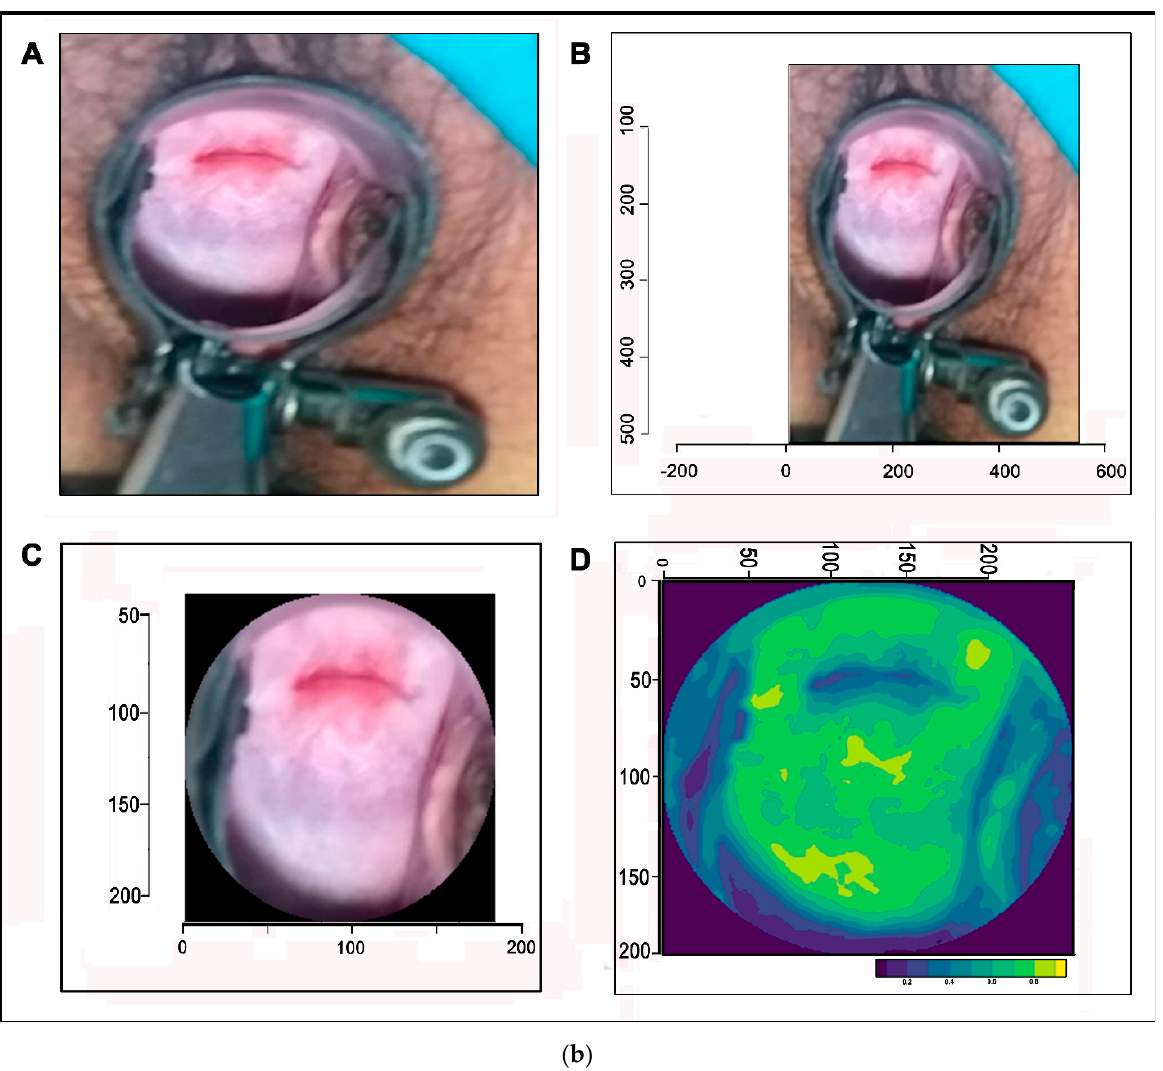
Figure 2. ( a ) Diagrammatic representation of the image processing of normal cervigrams: it de- picts the processing of the normal cervigrams A by subjecting it to preprocessing algorithms to remove the noise potentially interfering with the extraction of the image features before being processed with green channel color-coding algorithms and the Earth Mover’s Distance (EMD) algorithm to facilitate the assignment of a numerical score to the normal cervigrams and to rank them based upon their EMD score. Furthermore, separate images ( A – D ) of Figure 2a depicts the raw im- age ( A ) acquired from colposcope; then the image after preprocessing ( B ) followed by a cropped image, as shown in ( C ); and then the final color-coded image, as shown in ( D ) using green filter in R code, respectively. ( b ) Diagrammatic representation of the image processing of abnormal cervi- grams : it depicts the processing of the abnormal cervigrams ( A ) by subjecting it to preprocessing algorithms, as shown in ( B , C ), to remove the noise potentially interfering with the extraction of the image features before being processed with the green channel, as shown in ( D ), and the color-coding algorithms and Earth Mover’s Distance (EMD) algorithm to facilitate the assignation of a numerical score to the abnormal cervigrams and to rank them based upon their EMD score.